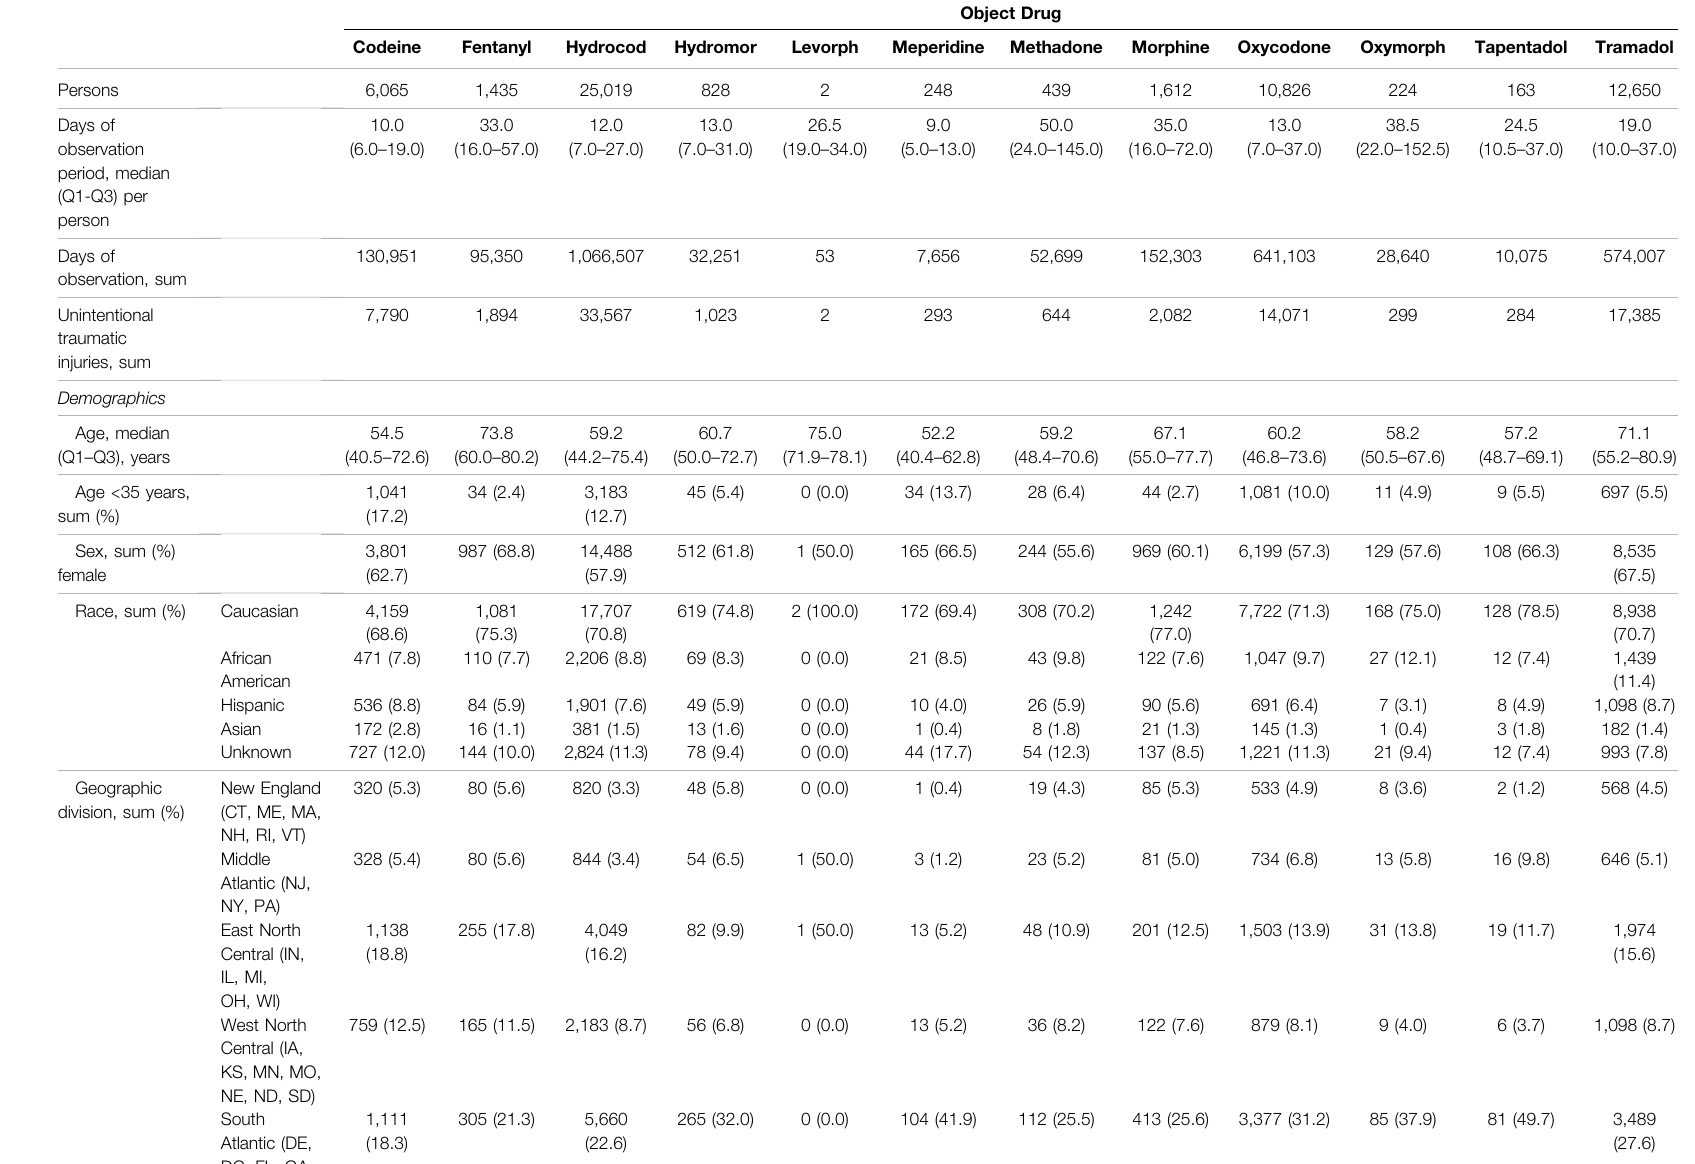
TABLE 1 | Descriptors of persons experiencing unintentional traumatic injury while receiving opioid object